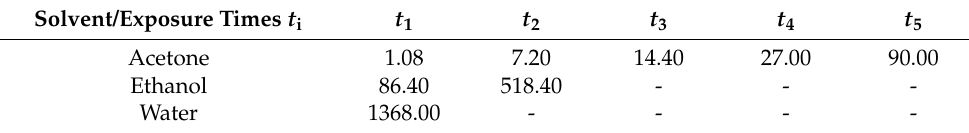
Table 1. Exposure times t i for solvent uptake considered in the present work (in 10 3 s). Solvent/Exposure Times t i